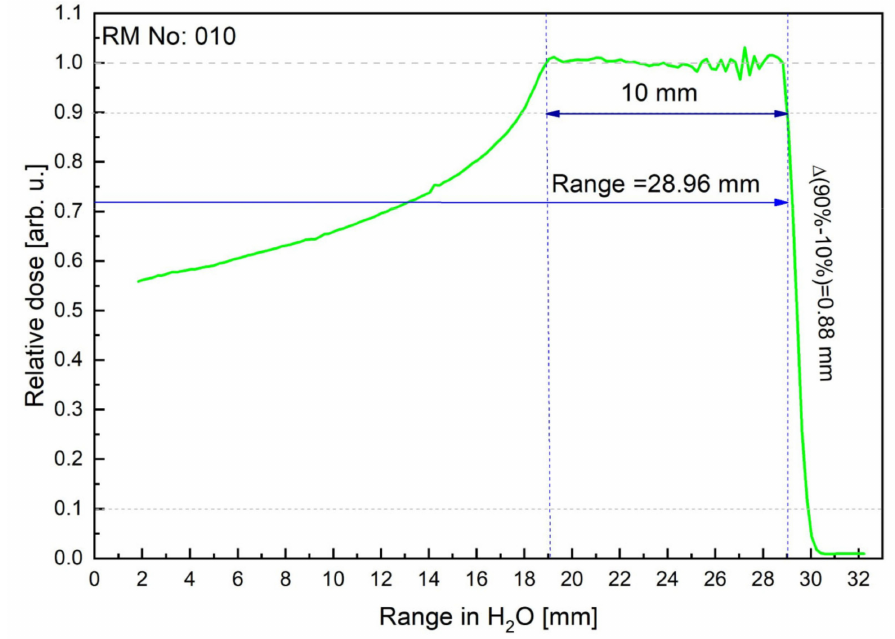
Figure 7. Proton depth dose distribution (the so-called spread-out Bragg Peak, SOBP) for the Markus ionization chamber (green solid line), measured using a 3D scanner and 10 mm collimator. The measured parameters: modulation = 10 mm; Range, R 90 = 28.96 mm; Distal fall-off ∆ (R 90% − R 10% ) = 0.88